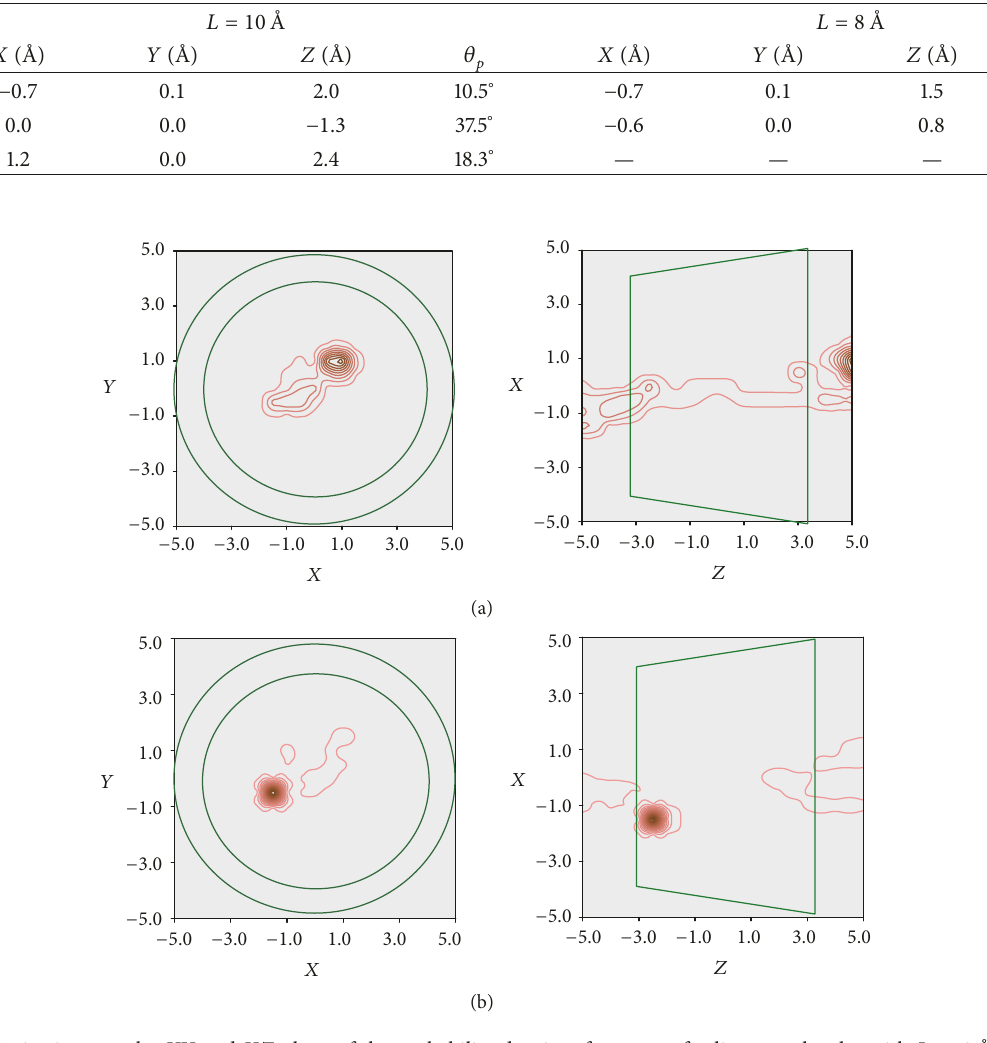
Figure 3: (a) Projections on the 𝑋𝑌 and 𝑋𝑍 plane of the probability density of presence for linear molecules with 𝐿 = 8 ˚A, 𝜎 1 = 3.0 ˚A, 𝜀 = 0.09 kcal/mol, 𝜎 = 3.5 ˚A, 𝜀 = 0.14 kcal/mol, and 𝑝 = 0.3 . A schematic representation of the projections of the cavity has been inserted 1 2 1 in the figure. (b) Same as (a) for linear molecules with 𝐿 = 10 ˚ A, 𝜎 1 = 2.5 ˚ A, 𝜀 1 = 0.07 kcal/mol, 𝜎 2 = 4 ˚ A, 𝜀 2 = 0.18 kcal/mol, and 𝑝 = 0.5